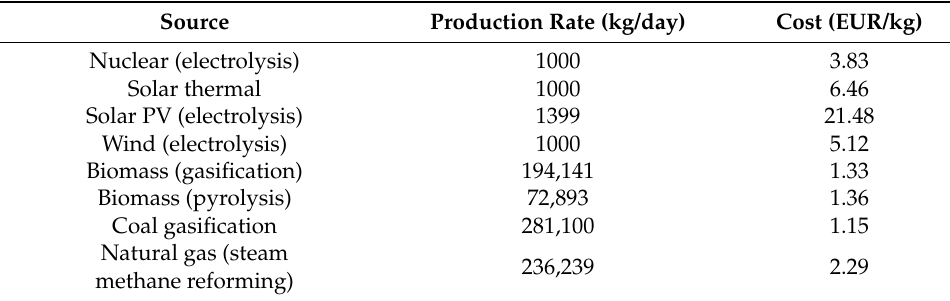
Table 4. Hydrogen production